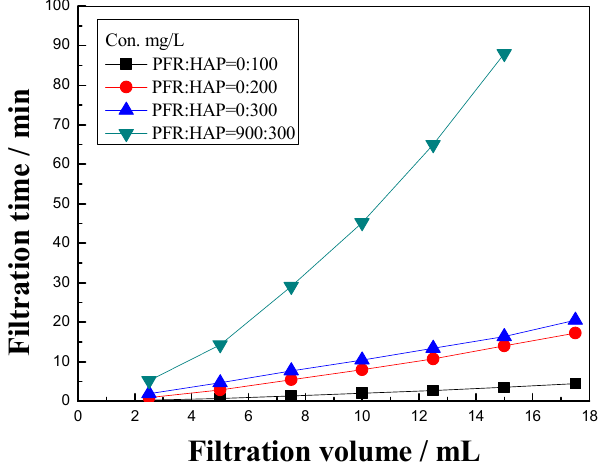
Figure 7. Filtration volume vs. filtration time curve of PFR/HAP dispersion and HAP solution prepared with simulated injection water.